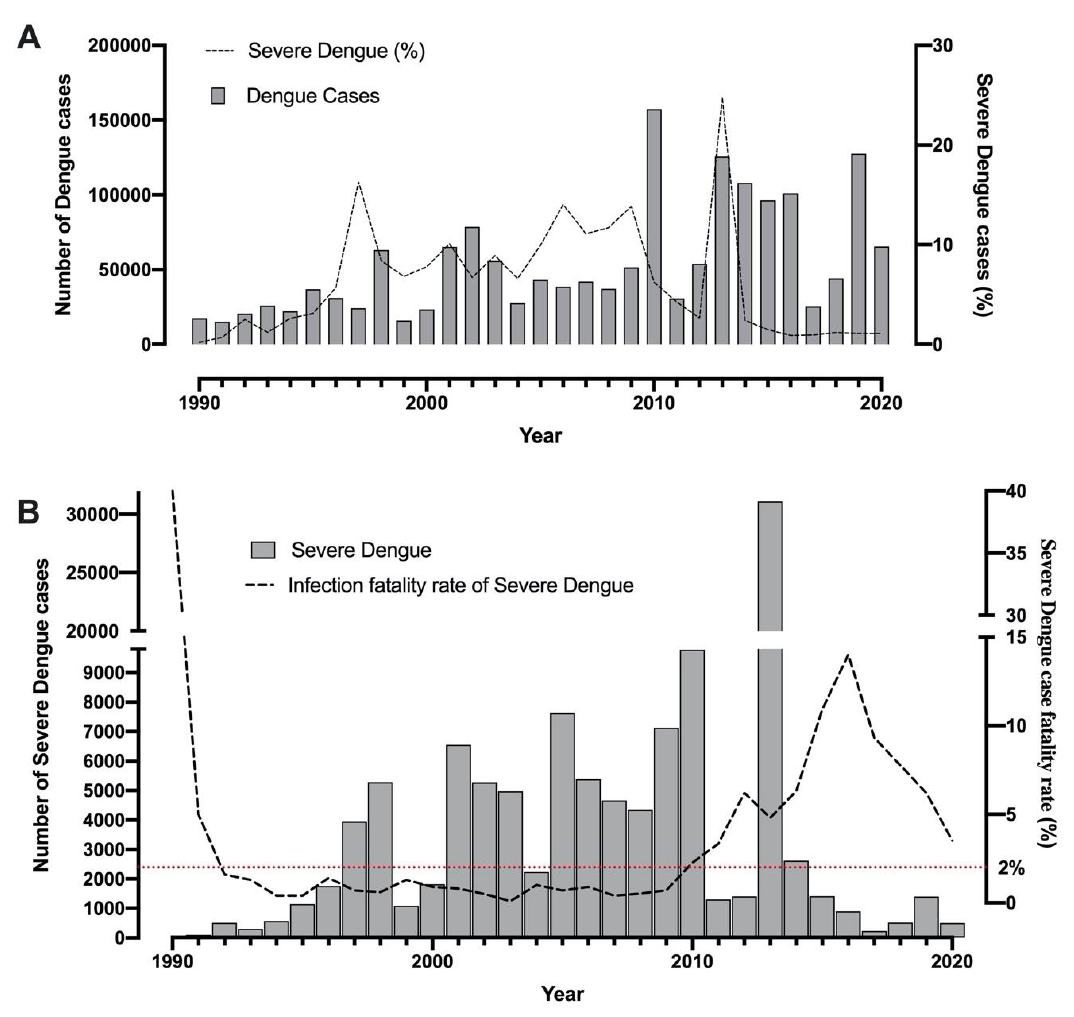
Figure 4. Reported cases and case fatality rate of severe dengue in Colombia: Total dengue cases and their respective percentages classified by severe dengue cases ( A ); severe dengue cases and their respective case fatality rate by year. The red dotted line represents the Colombia government’s goal for the infection fatality rate in severe dengue cases ( B ). [9,13 − 28] .